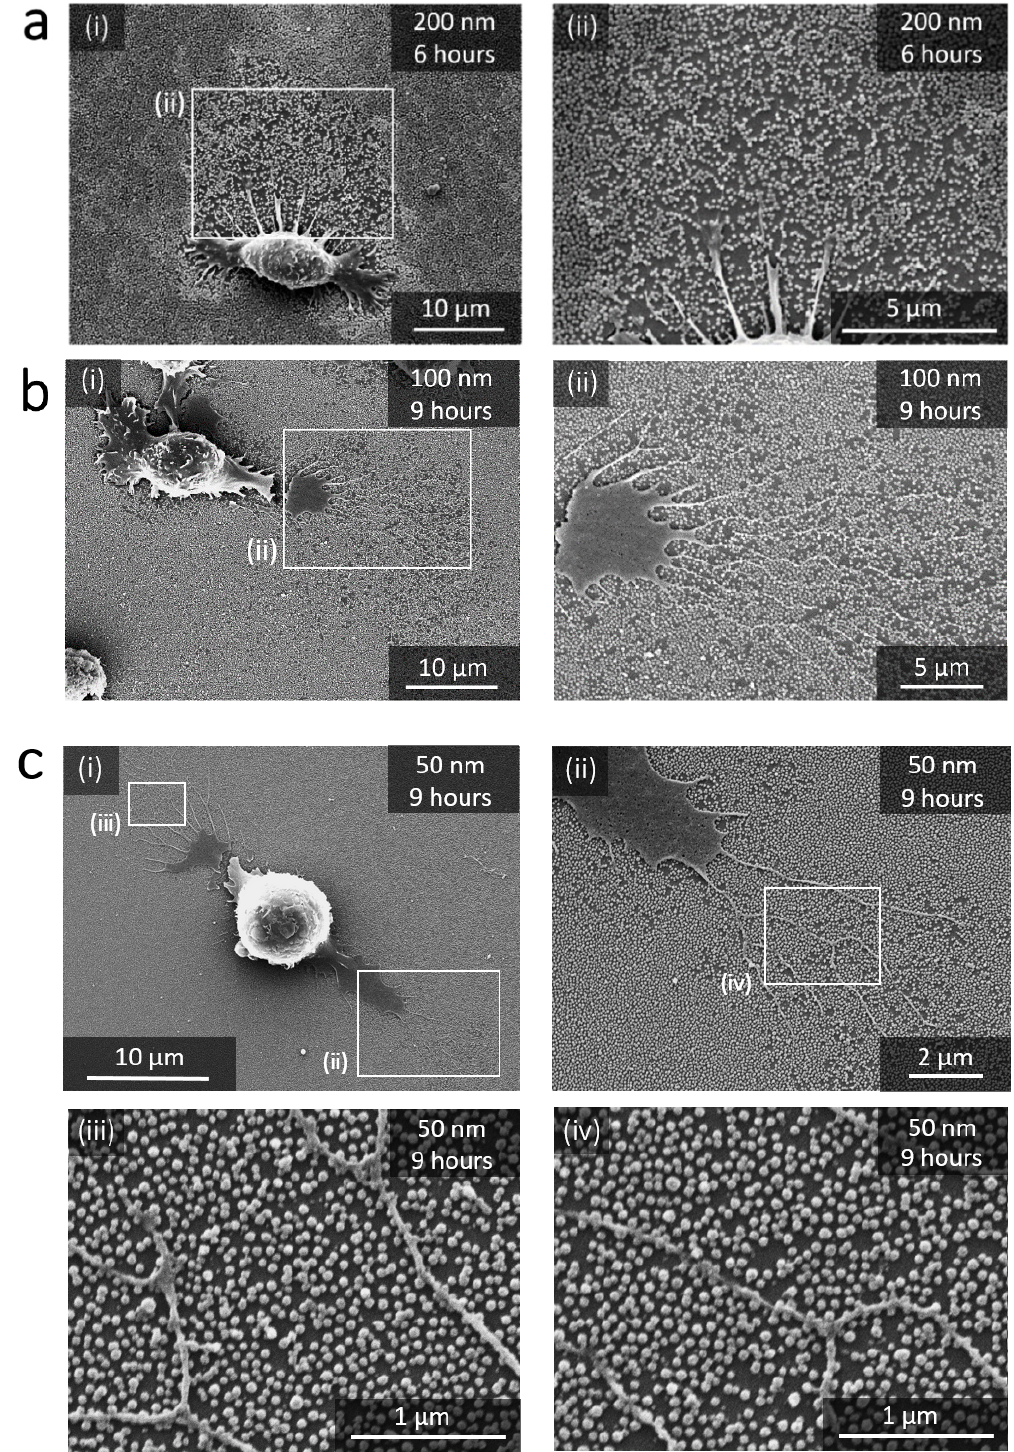
Figure 3. SEM images of macrophages adhering to substrates decorated with 200 nm, 100 nm and 50 nm NPs. ( a ) 200 nm silica NPs after 6 h of incubation at two magnifications (i) and (ii). ( b ) 100 nm silica NPs after 9 h of incubation at two magnifications (i) and (ii). ( c ) 50 nm silica NPs after 9 h of incubation (i) and at three different spots around the cells at a higher magnification, from (ii) to (iv).